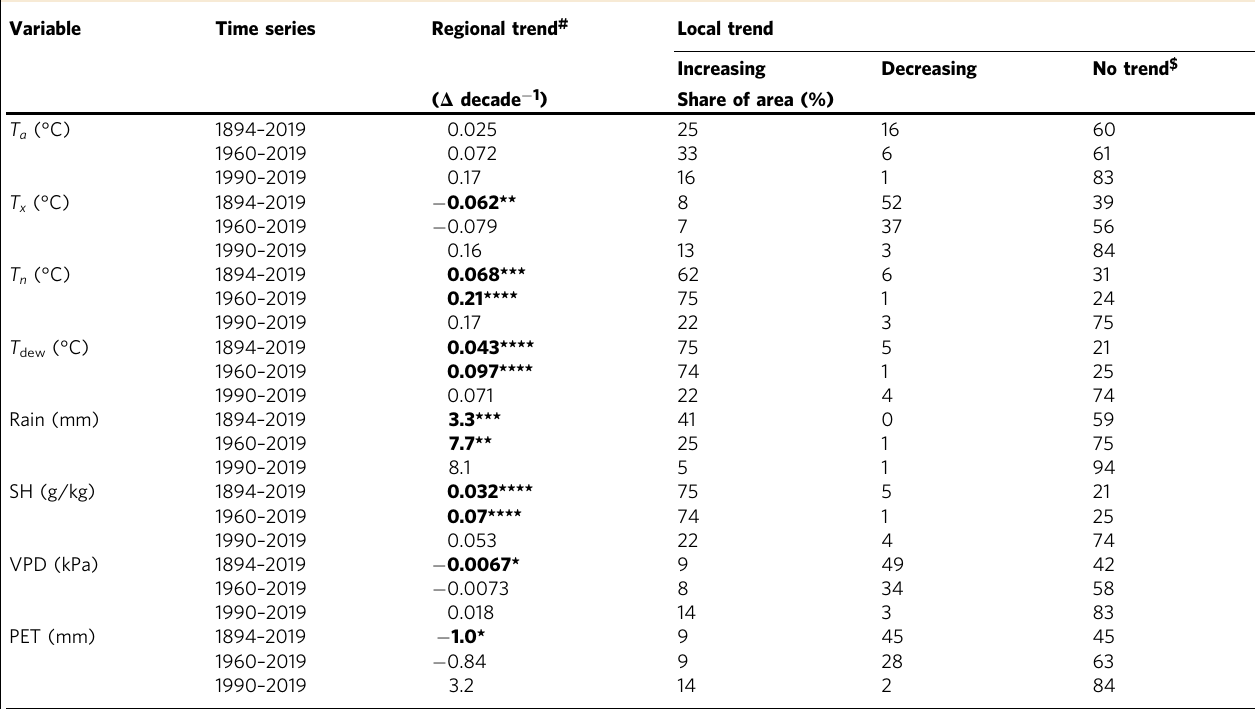
Table 1 Summary of regional and local trends for the three time series.